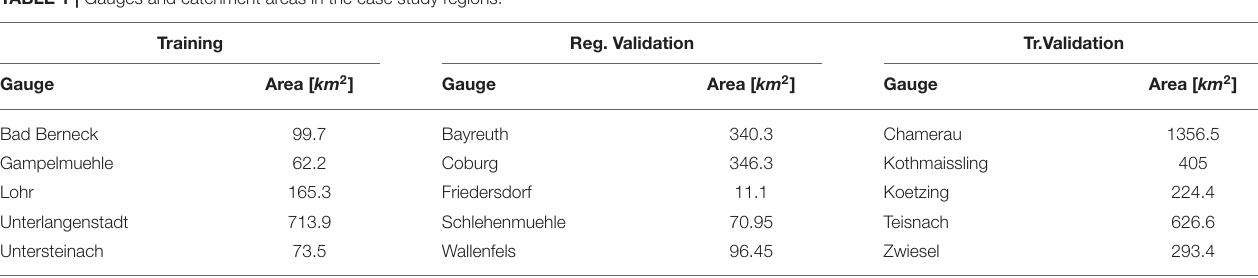
TABLE 1 | Gauges and catchment areas in the case study regions. Training Reg. Validation